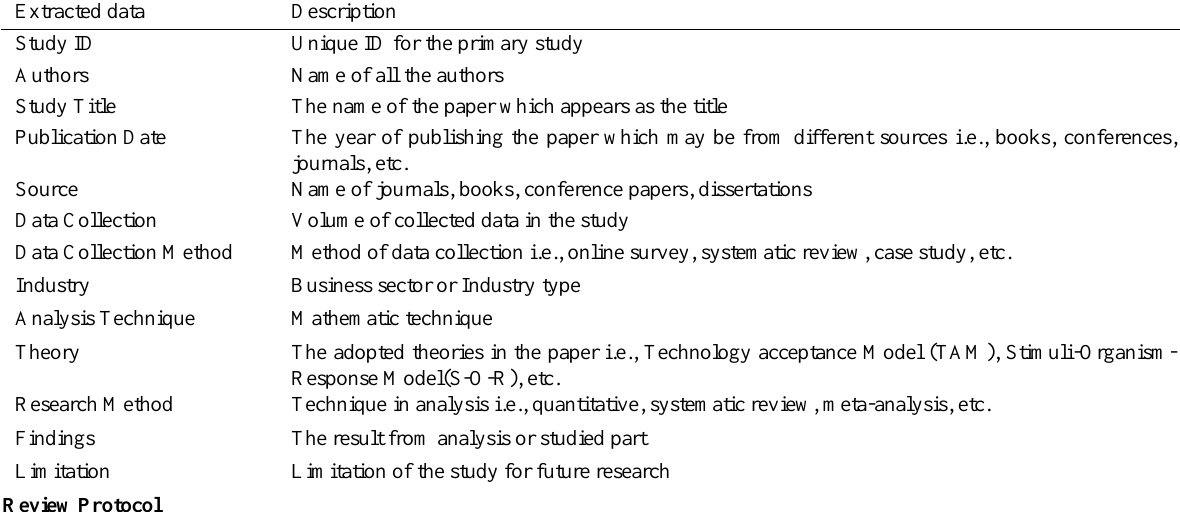
Table 1: Data extraction of primary